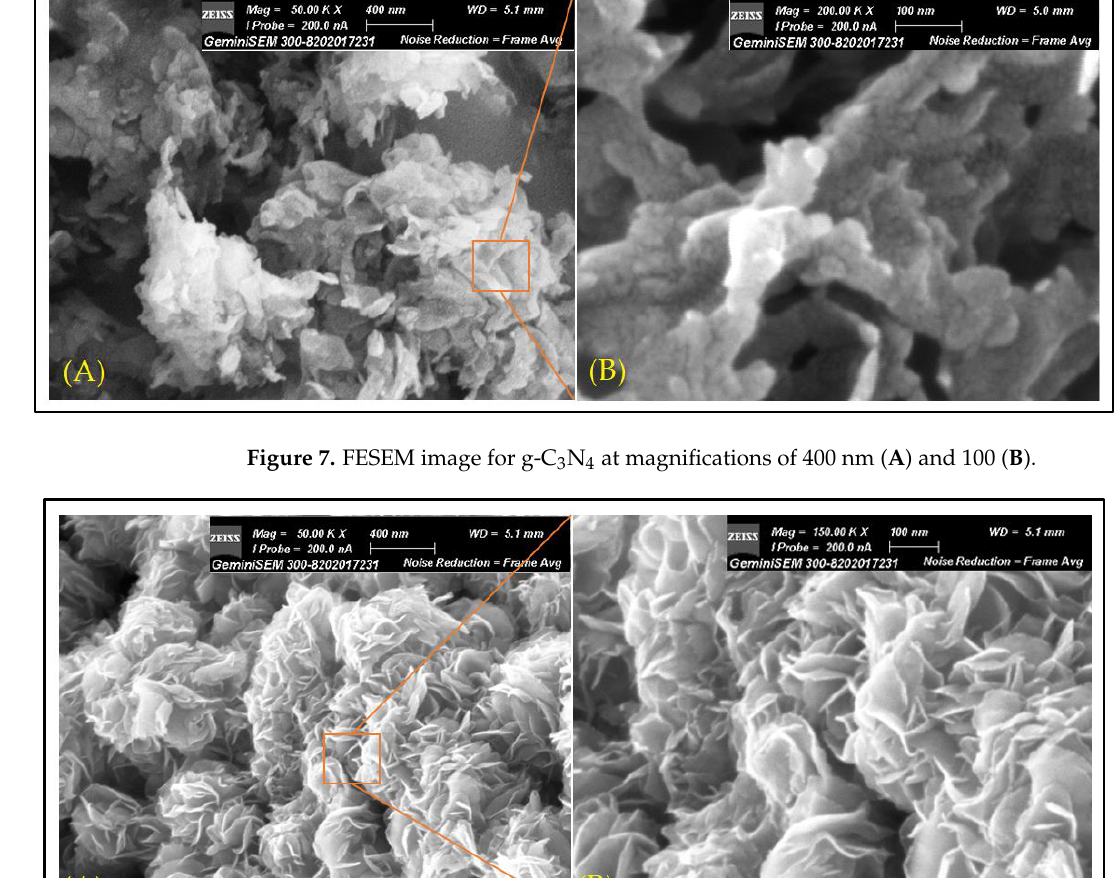
3 N 4 /MoS 2 at magnifications of 400 nm ( A ) and 100 ( B ).